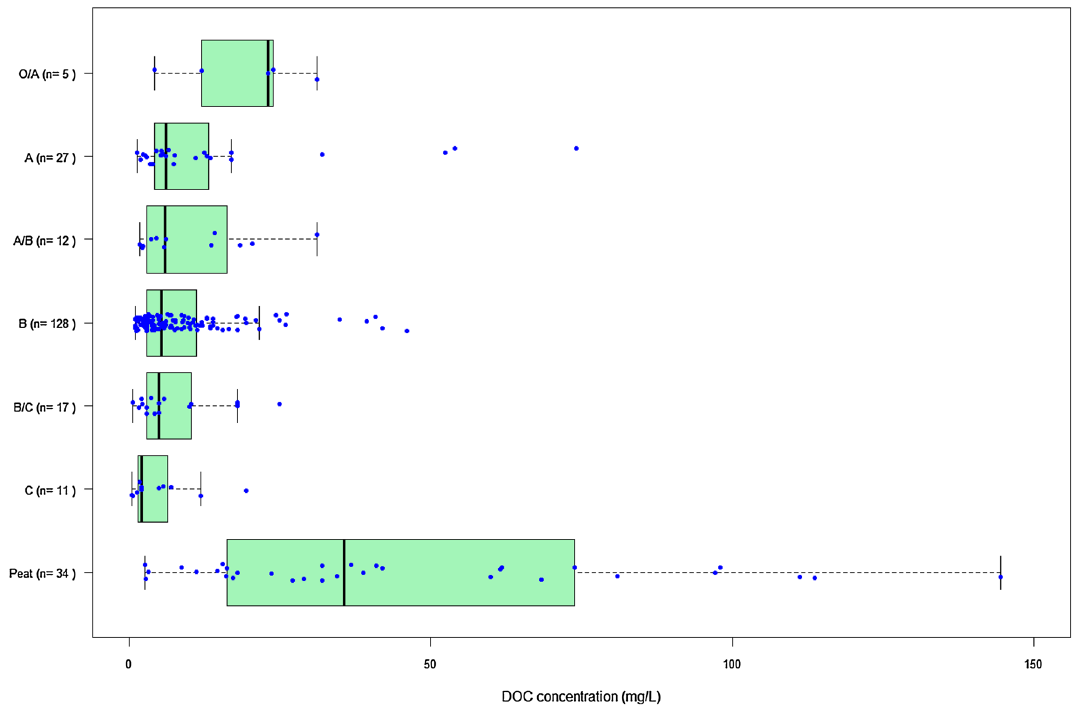
bution. Boxplot bars are medians. Whiskers extend up to 1.5 times the interquartile range (IQR) from the lower and upper quartile, unless exceeding the minimum or maximum. Individual data are jittered for visualization